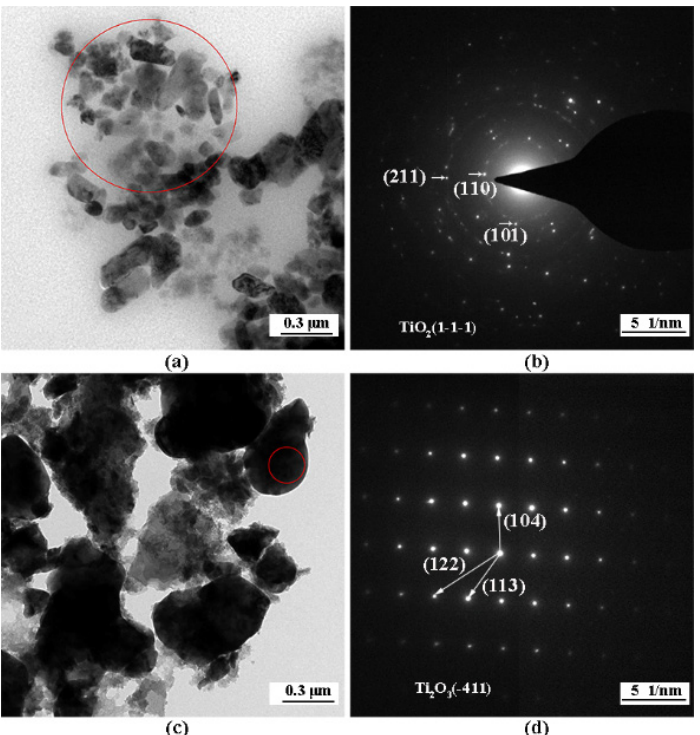
Figure 8. TEM images of MnZn ferrite surface particles: ( a ) MnZn ferrite immersed in molten salt for 2 min; ( b ) the corresponding SAD pattern of ( a ); ( c ) immersed in molten salt for 20 min; ( d ) the corresponding SAD pattern of ( c ). The indexing indicates the existence of a TiO 2 phase for 2 min and a Ti 2 O 3 phase for 20 min.